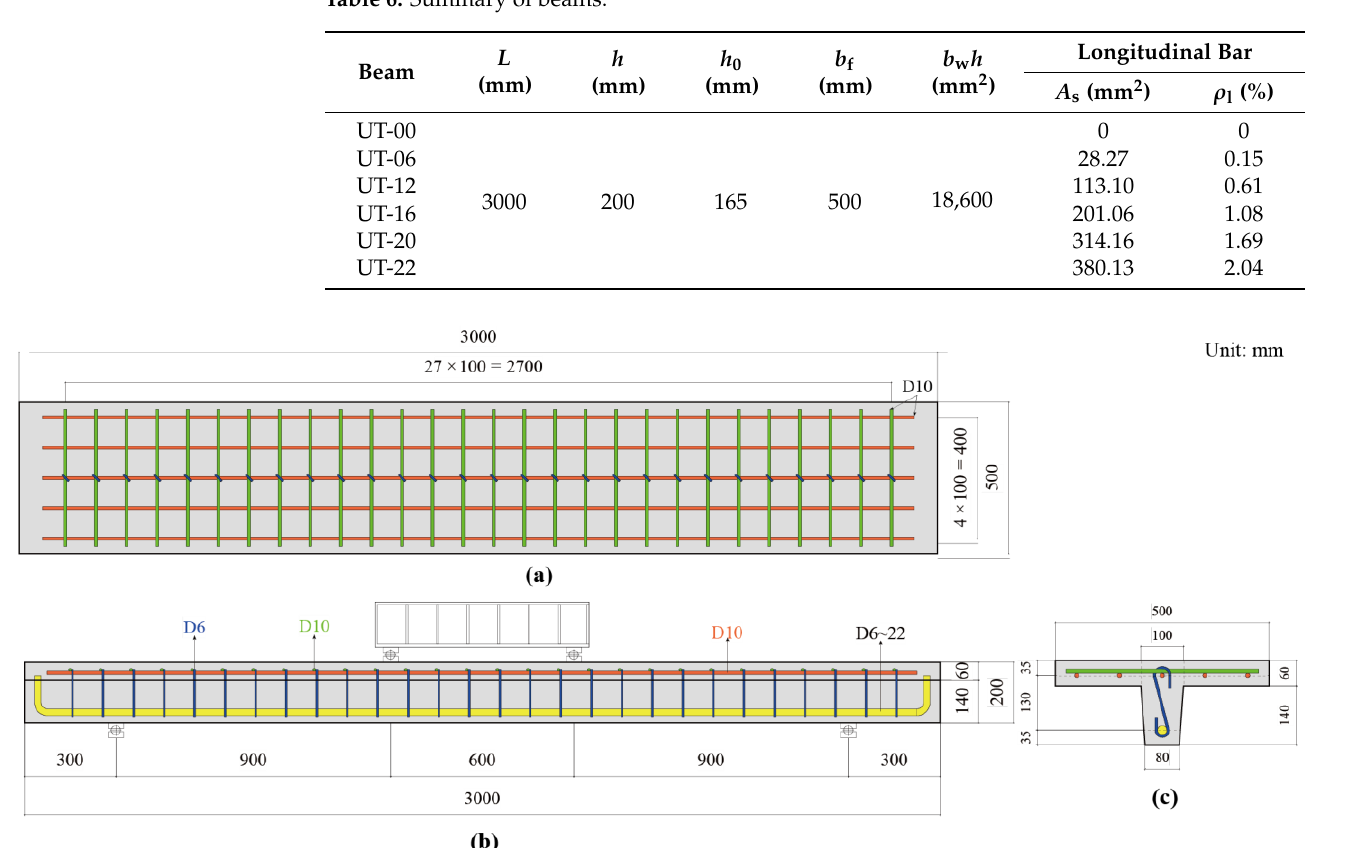
Table 6. Summary of beams.